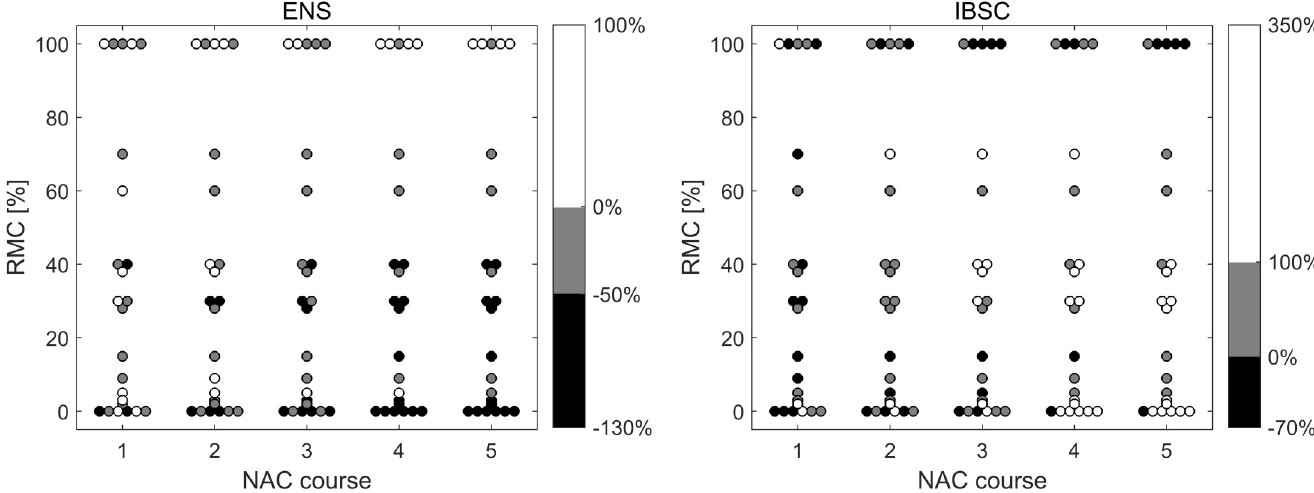
Fig 4. Relative changes in the values of ENS and IBSC, depending on the value of postoperative RMC and the number of NAC doses.